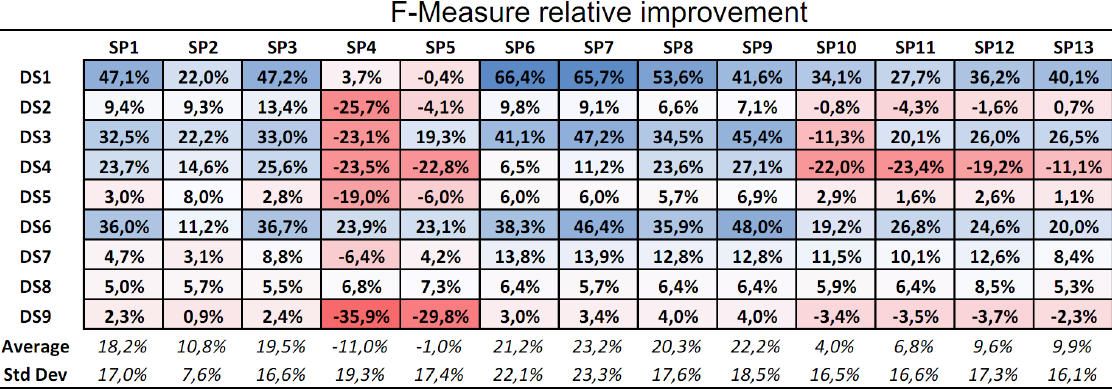
Table 3: Results of the experiments on several data sets. For each data set, the F1-measure of each experiment is presented as a relative improvement of the baseline